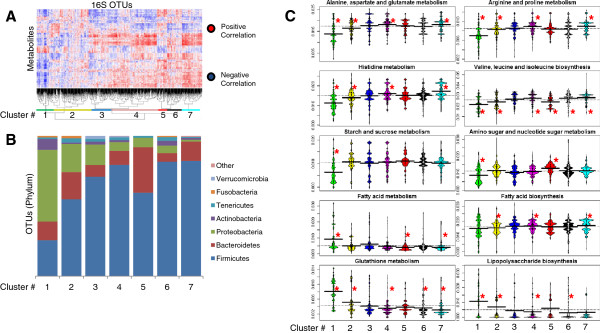
Sigmoid microbial clusters. Heat maps were created that were sorted based on hierarchical clustering of both bacteria and metabolites (A). The microbial dendrograms were then cut such that six or seven microbial clusters were generated based on k-means prediction strength. The number and horizontal span of each cluster is indicated at the bottom of the dendrogram. The proportion of the phylotypic clades comprising each cluster is depicted for each cluster (B). To determine the differences in imputed metagenomic enrichments/depletions of Kyoto Encyclopedia of Genes and Genomes (KEGG) pathways between clusters, the metagenomic composition of each operational taxonomic unit (OTU) was then computed using reconstruction of unobserved states (PICRUSt) and quantitatively analyzed for relative genomic pathway abundance using Unified Metabolic Analysis Network (HUMAnN) and Kruskal-wallis one way analysis of variance. Only pathways that significantly varied in at least one cluster (Bonferroni, P <0.05) are shown (C). Beanplot colors differentiate cluster numbers; *Bonferroni, P <0.05.